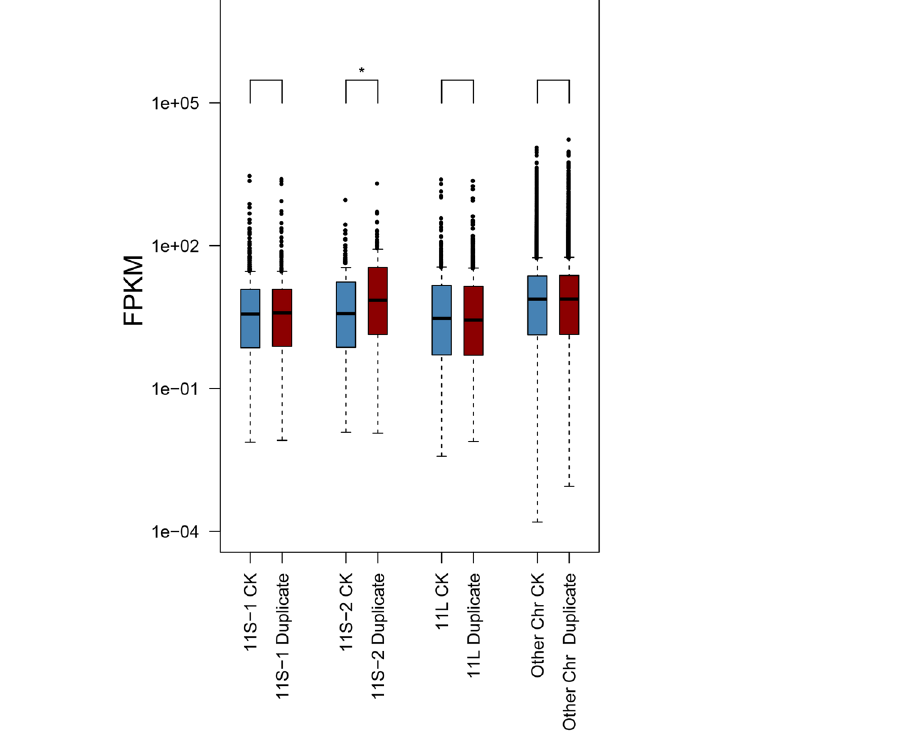
Figure 7. Kolmogorov-Smirnov tests of genes expression level between the normal diploid and 11S-2 region. Y-axis represent genes expression level